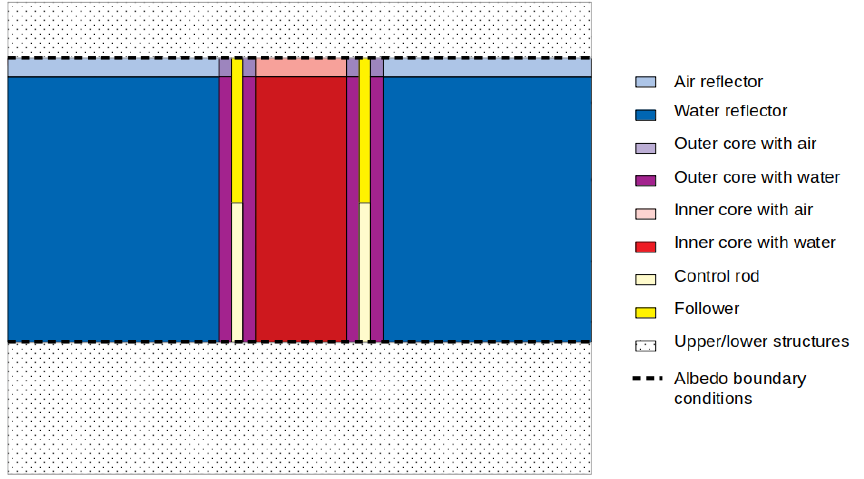
Figure 2. Geometry used for GeN-Foam calculations along with the name of the universes used in Serpent for cross-section